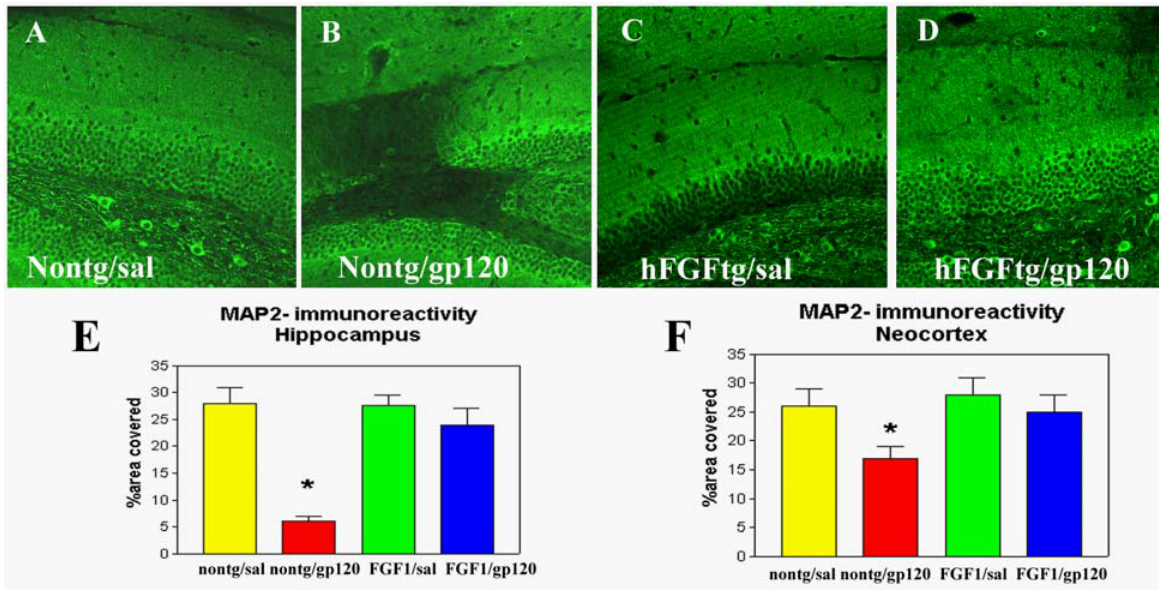
Figure 3. Protective effects of FGF1 expression against the toxic effects of HIV-gp120 in mice injected with gp120 protein. (a) Nontg mouse injected with saline. (b) A prominent lesion developed in nontg mice injected with gp120 protein. (c) hFGF1 tg mouse injected with saline. (d) In hFGF1 tg mice injected with gp120, the neurons are protected and no lesion is observed. (e) Semi-quantitative analysis of levels of MAP2 immunoreactivity in the hippocampus. (f) Semi-quantitative analysis of levels of MAP2 immunoreactivity in the